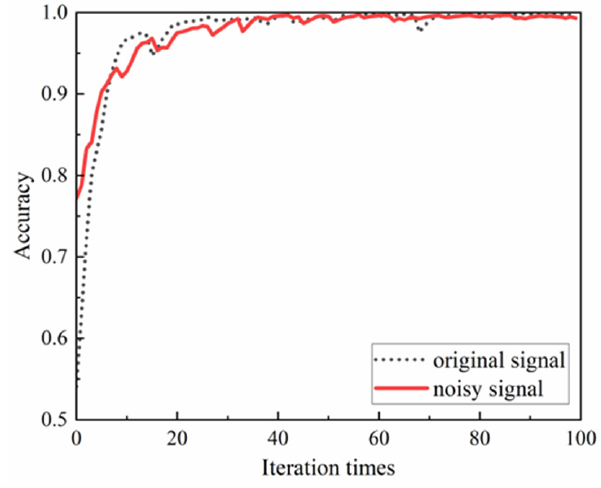
Figure 19. Comparison of accuracy change curve of test set before and after noise addition.